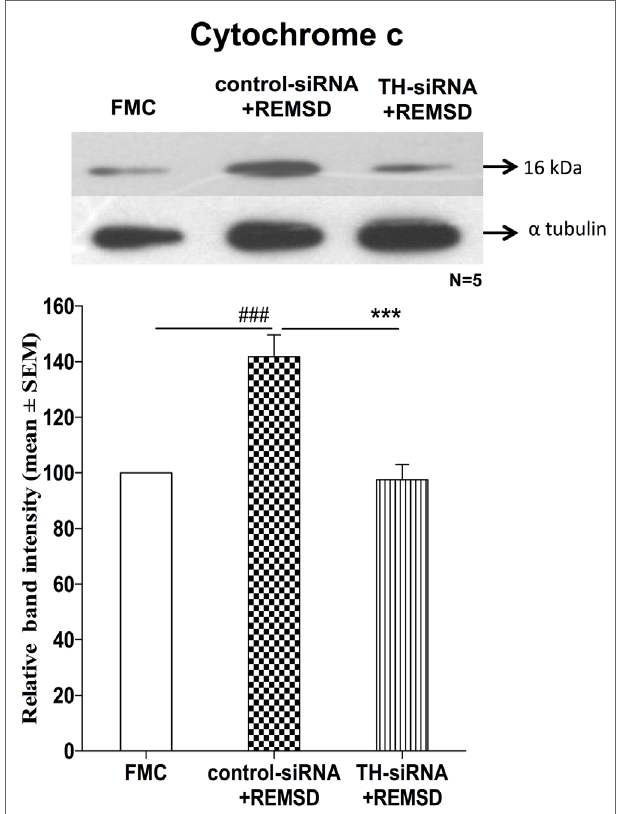
FigUre 11 | expressions of cytochrome c in homogenate reMsD rat brain after microinjection of Th-sirna or control sirna bilaterally into lc . Upper panel shows a representative Western blot of cytochrome c . Histogram in the lower panel shows percent changes in the mean ( ± SEM) band densities of the blots as compared to FMC taken as 100% in five sets of experiments. Abbreviations are as in the text. Significance levels are between the treatments of connecting horizontal bars; significance levels – *** p < 0.001 and ### p < 0.001, * as compared to TH-siRNA and # as compared to